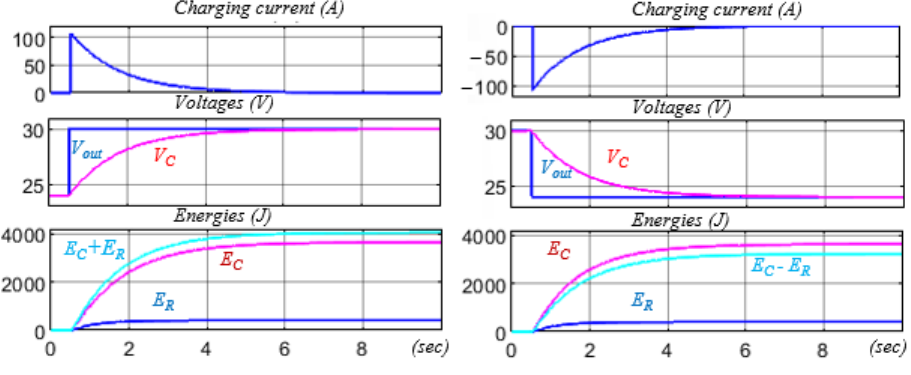
Figure 7. SC charging and discharging with a constant voltage.